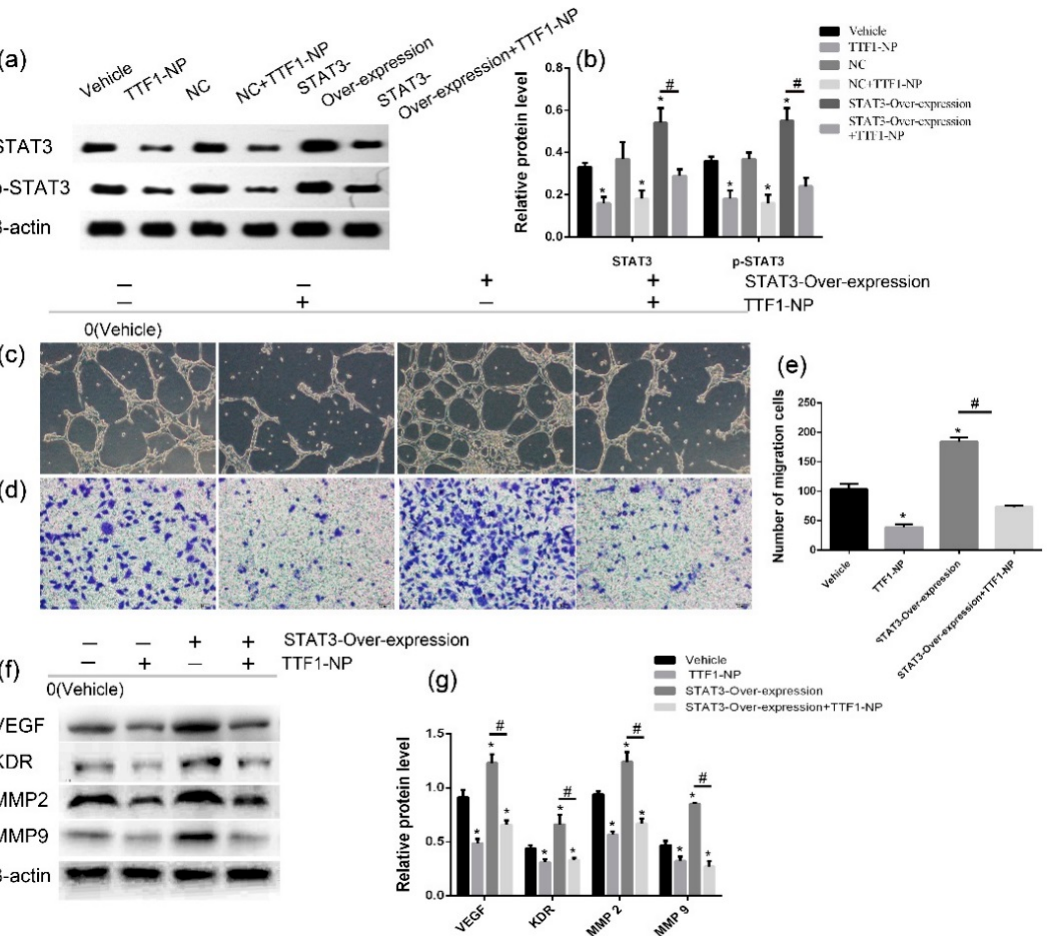
Figure 6. TTF1-NP suppressed angiogenesis and cell migration in STAT3 Over-expressing HepG2 cells. ( a ) The STAT3 and p-STAT3 protein levels in HepG2 cells transfected with STAT3 plasmid